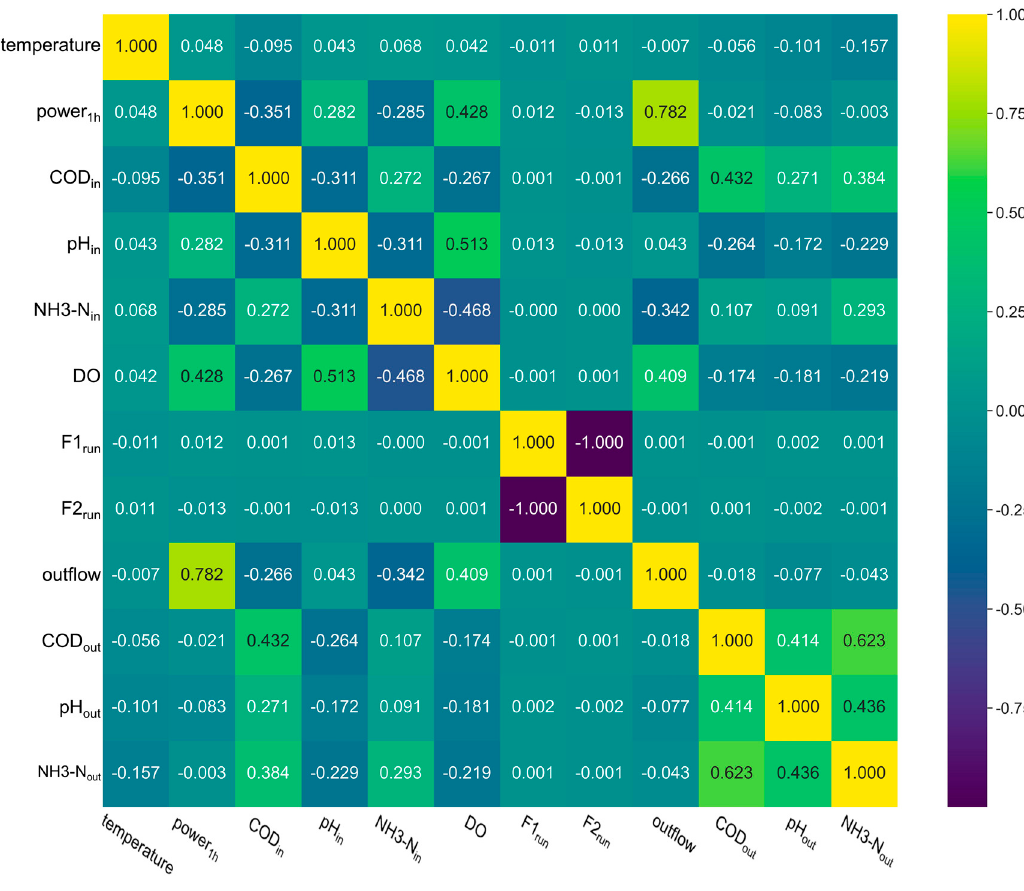
Figure 3. Pearson’s correlation of the input parameters.